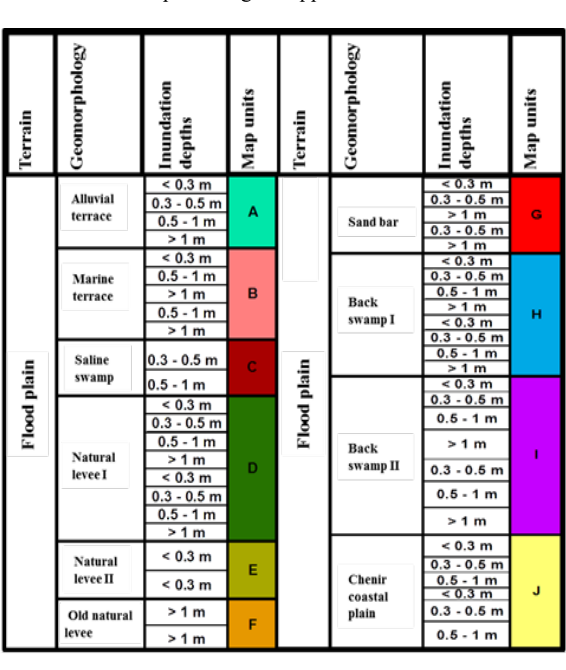
Figure 7. The detailed legend of the Landscape-ecological